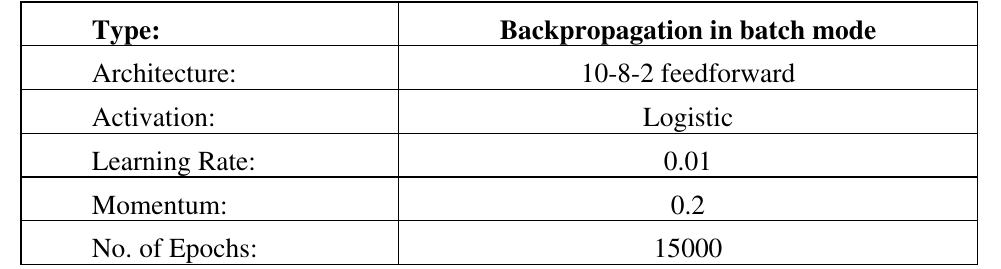
Table 3. ANN training